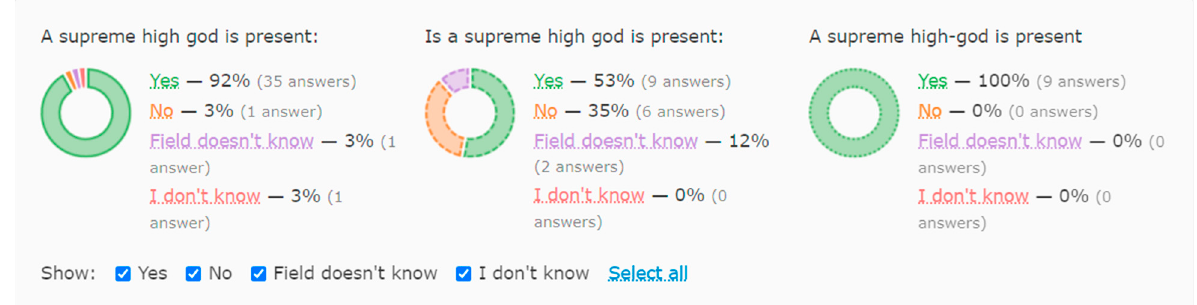
Figure 6. DRH visualization of the query “ A supreme high god is present ?” from 395–1204 CE focusing on the broader Mediterranean and Near East regions. The pie charts represent the “Group”, “Place”, and “Text” polls, ordered from left to right.